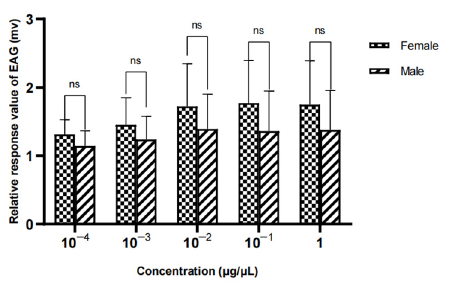
Figure 25. Comparison of EAG responses of W. magnifica to 1-octen-3-ol.